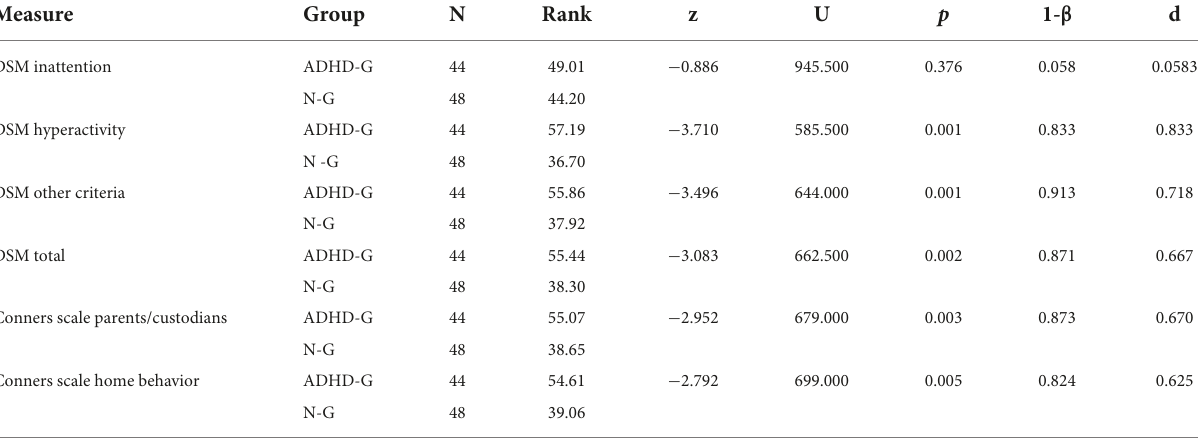
TABLE 2 Differences between groups for scales means (excepting EDAH and SDQ-Cas) ( N = 92). Measure Group